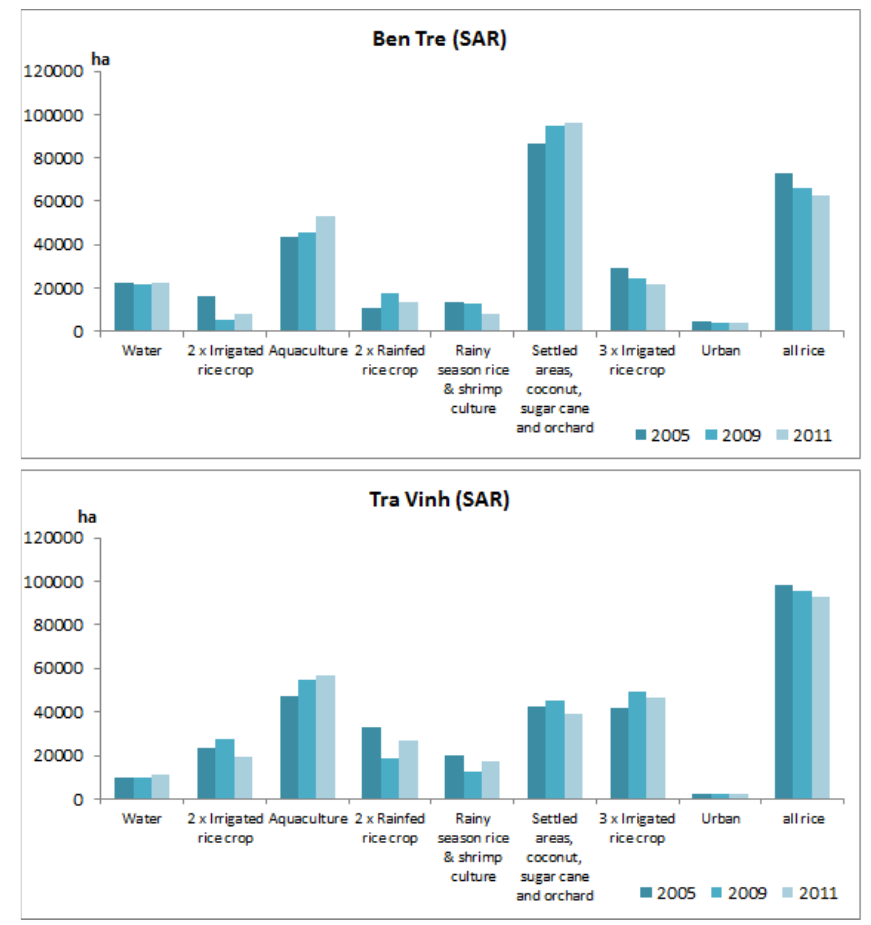
Figure 6. The total acreages of land-use classes in Ben Tre and Tra Vinh provinces based SAR images for 2005, 2009 and 2011. “All rice” is the sum of 2 × irrigated, 2 × rainfed and 3 × irrigated rice crop.